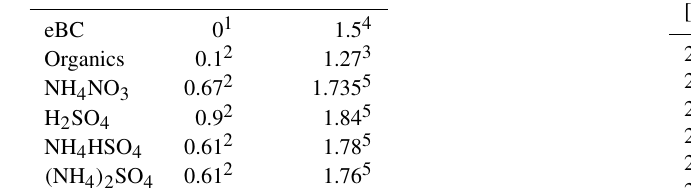
Table 2. Summary of takeoff and landing times of the respective flights of HOPE. Flight Takeoff